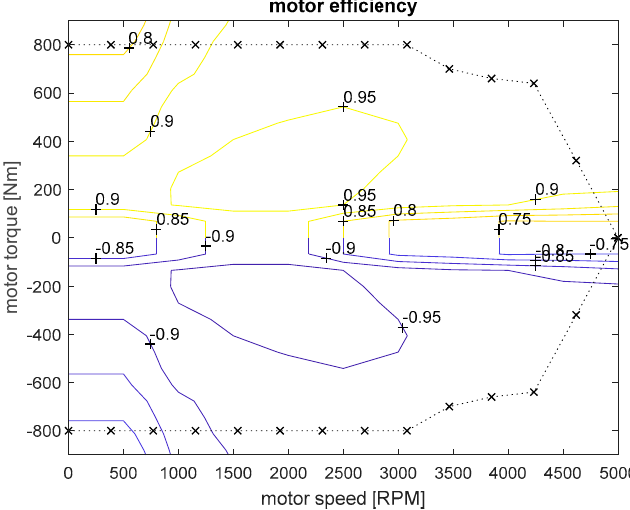
Figure 2. Efficiency of electric motor. Figure 2. E ffi ciency of electric